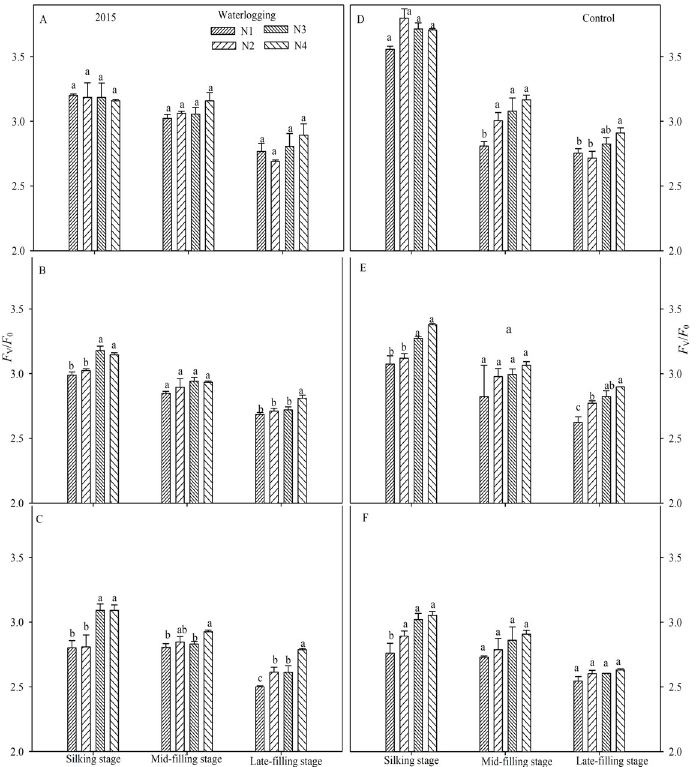
Fig 6. Potential efficiency of PSII ( F v / F 0 ) in different leaf layers under different N treatments (2015). The error bars represent the standard errors of the mean. Different letters above the bars indicate significant differences ( p < 0.05) among the different N treatments. A,D: above-ear leaves; B,E: ear leaves; C,F: below-ear leaves. N1: 100% N applied as basal fertilizer, N2: 70% N applied as basal fertilizer and 30% N applied at the jointing stage, N3: 50% N applied as basal fertilizer and 50% N applied at the jointing stage, N4: 30% N applied as basal fertilizer, 50% N applied at the jointing stage and 20% N applied at the big flare stage.